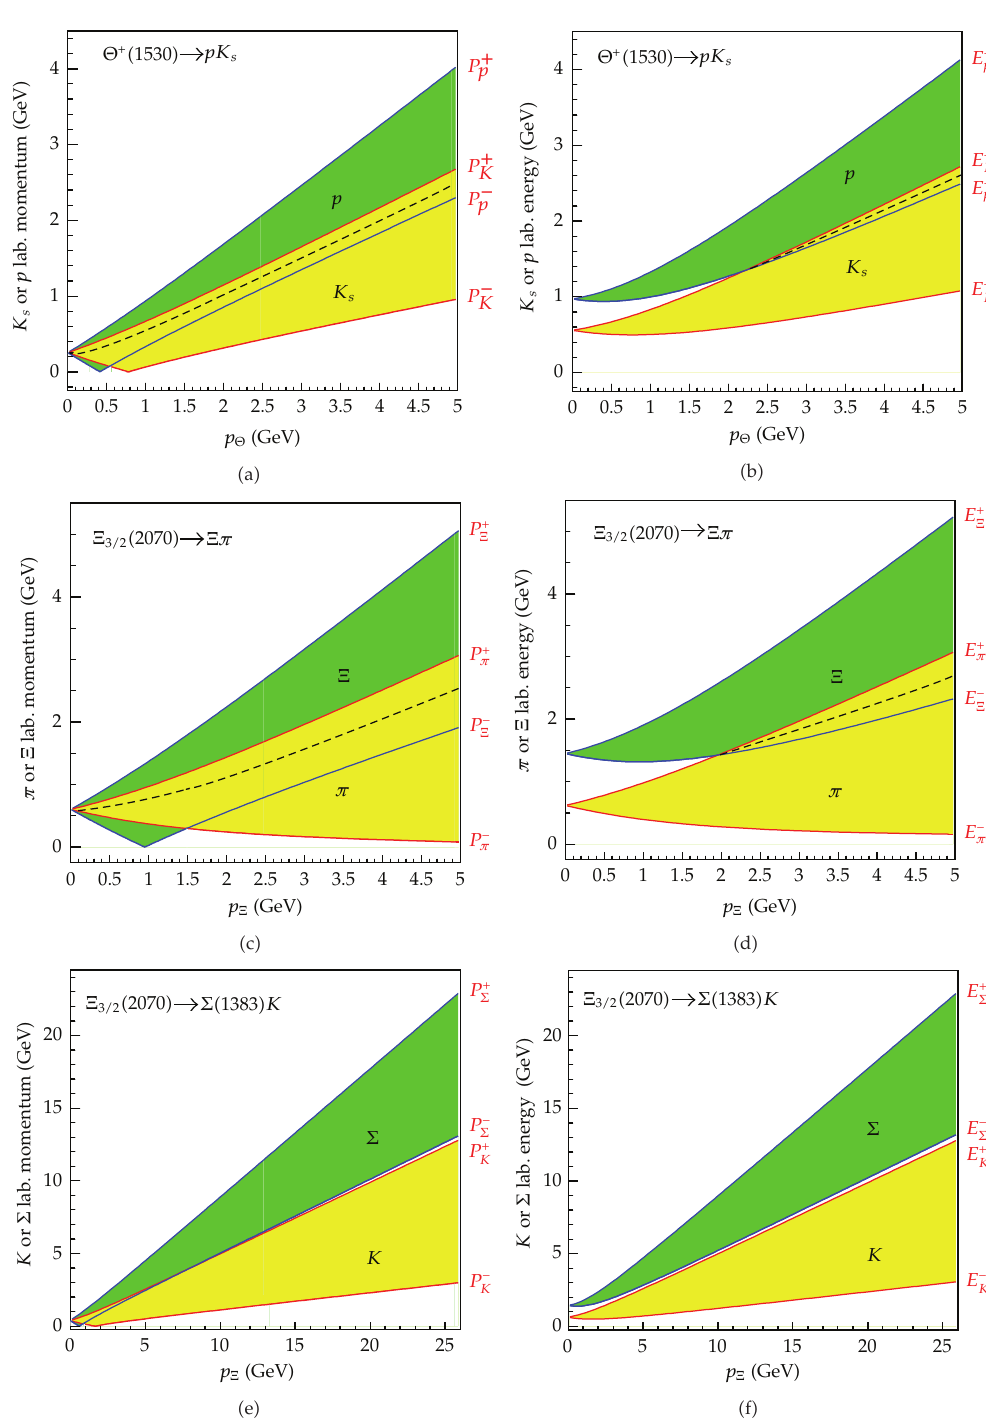
Figure 3: Phase space m -bands (cid:3)(cid:3) a (cid:4) , (cid:3) c (cid:4) , and (cid:3) e (cid:4)(cid:4) and E -bands (cid:3)(cid:3) b (cid:4) , (cid:3) d (cid:4) , and (cid:3) f (cid:4)(cid:4) in decays of the pentaquark states Θ(cid:3) 1530 (cid:4) and Ξ 3 / 2 (cid:3) 2070 (cid:4) . The dashed lines correspond to (cid:3) 2.12 (cid:4) and (cid:3) 2.20 (cid:4)